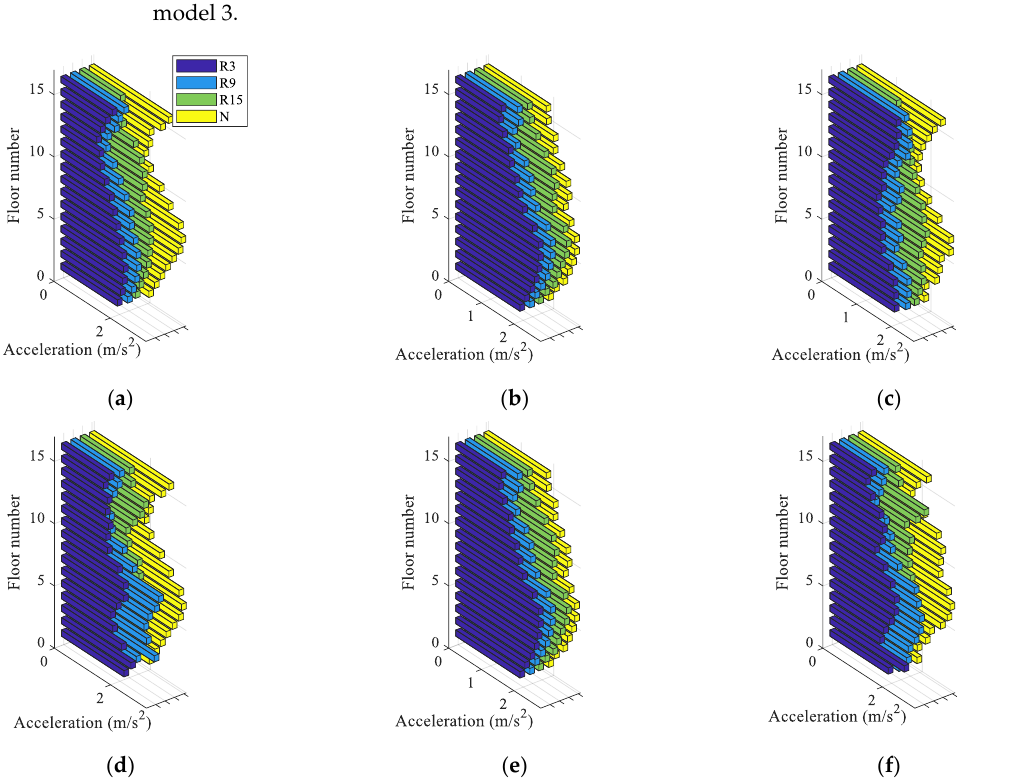
Figure 15. Absolute acceleration (El Centro) : ( a ) left building of model 1; ( b ) left building of model 2; ( c ) left building of model 3; ( d ) right building of model 1; ( e ) right building of model 2; ( f ) right building of model 3.